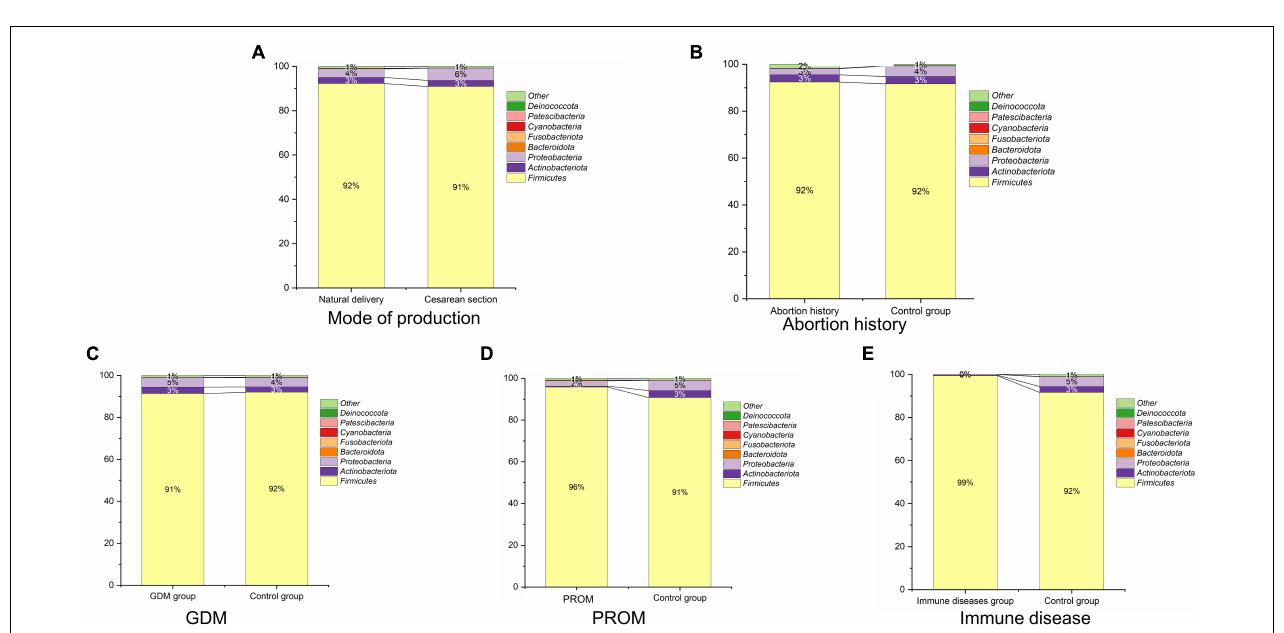
group, and biosynthesis of vancomycin group antibiotics, glycosaminoglycan biosynthesis—chondroitin sulfate/dermatan sulfate was less active ( Figure 5B ). In PROM groups, there